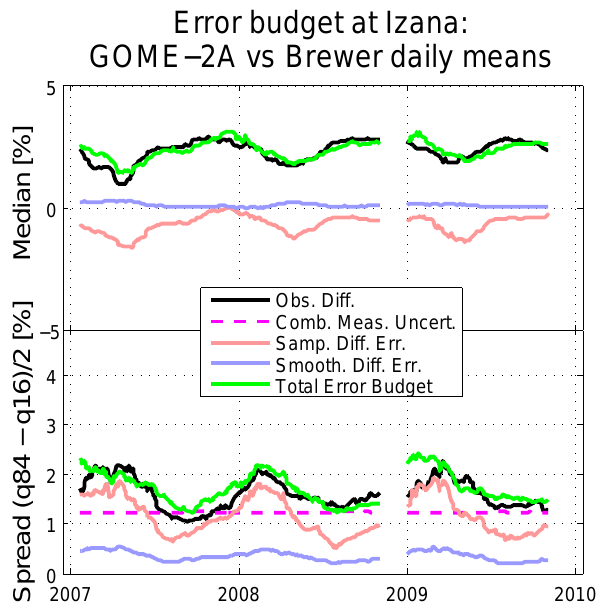
Figure 12. Error budget of the GOME-2/MetOp-A vs. Brewer daily mean comparisons at Izaña, derived from simulation based on MERRA fields rather than IFS-MOZART fields.